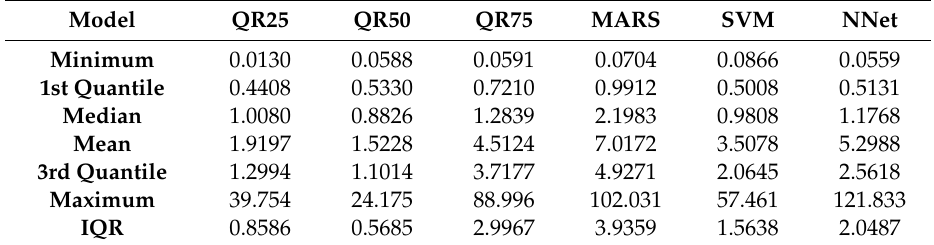
Table 10. Summary Statistics of Absolute Percentage Errors of ROI for Each Model for Year 2015 with 2010–2014 Years data (out of sample forecast).